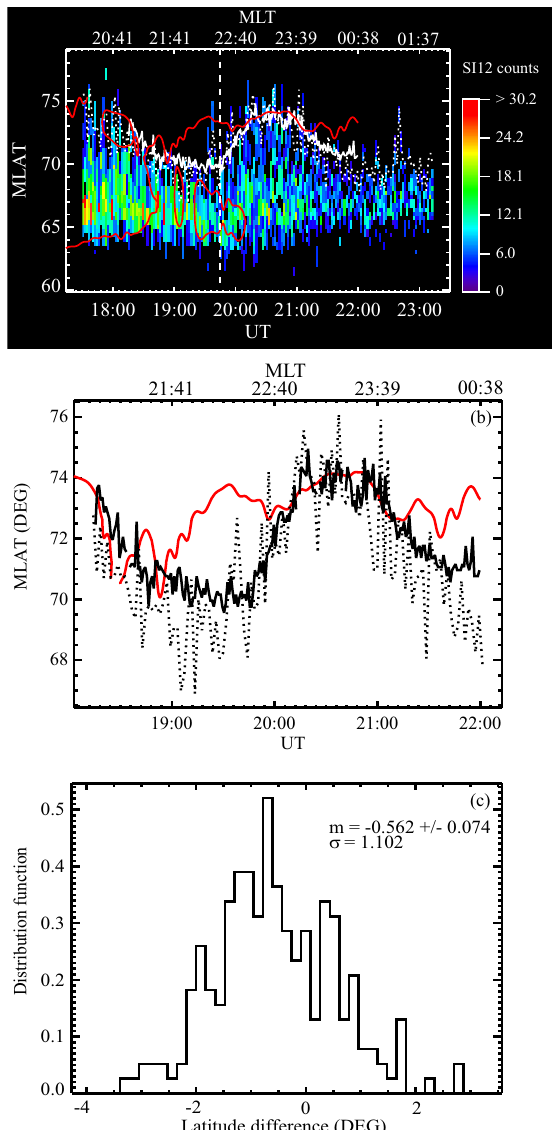
Fig. 2. (a) Keogram of SI12 counts along the meridian correspond- ing to the EISCAT field of view on 22 September 2001. The over- laid white solid line represents the location of the EISCAT PCB, the dotted lines show the SI12 PCB, and the red solid lines repre- sent the MCRBs as determined using the MIRACLE magnetometer data. The vertical dashed line indicates the beginning of net flux closure. (b) Blowup of the polar cap boundaries determined dur- ing the interval with simultaneous EISCAT observations, with the same line conventions as in panel (a). (c) Distribution function of the difference between the latitude of the SI12 and EISCAT